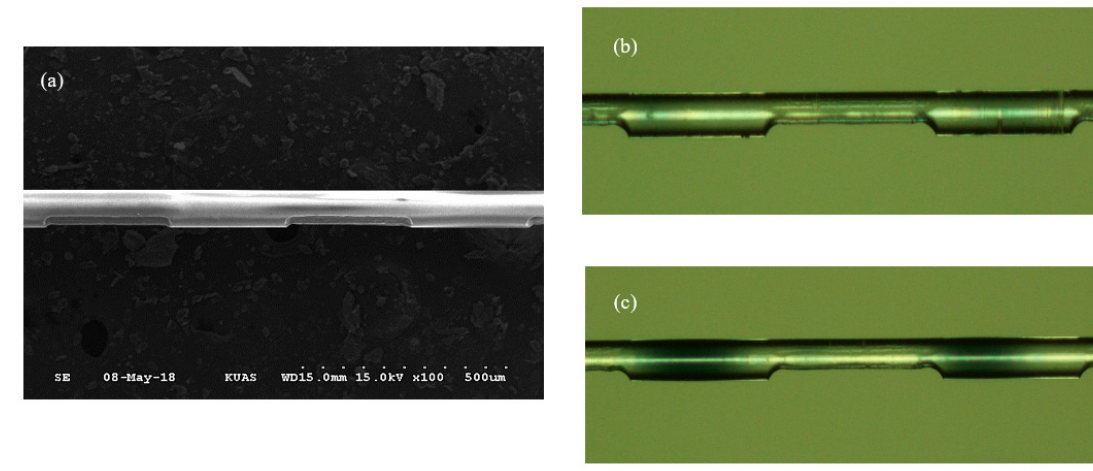
Figure 2. ( a ) SEM image of the optical fiber with the incident laser beam on the grating depth during wet etching; ( b ) microscan photo of the optical fiber with the incident laser beam on the grating depth during wet etching; ( c ) microscan photo of the optical fiber after polymer coating.